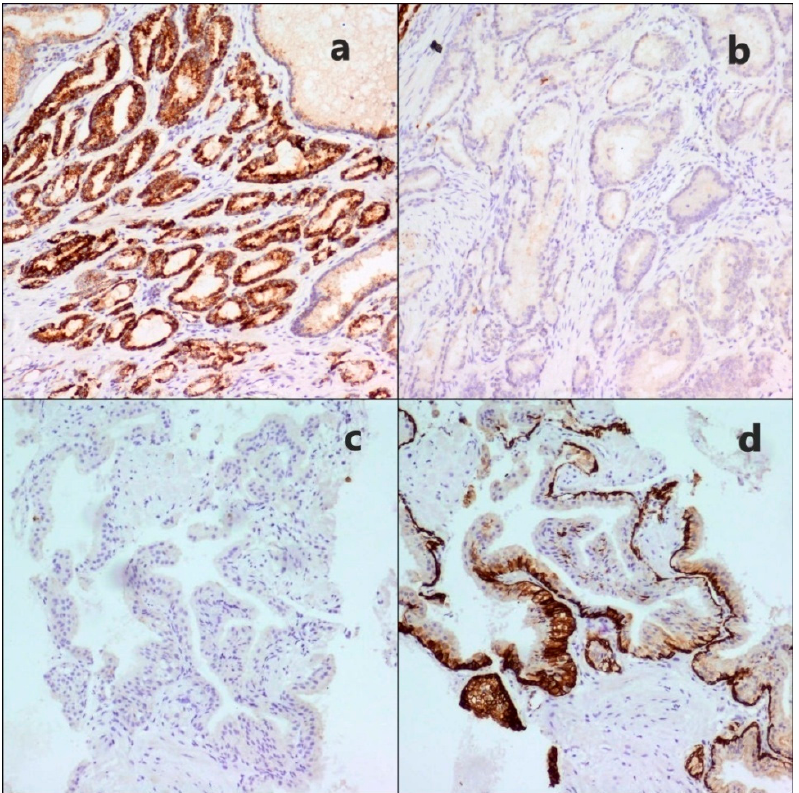
Figure 1. Comparison of immunohistochemical characteristics of prostate cancer and benign hy- perplasia. ( a ) Diffuse intense cytoplasmic staining of the neoplastic glands of adenocarcinoma with Alpha-Methylacyl-CoA Racemase (AMACR), ×40. ( b ) Negative basal cell staining with high-molecular-weight cytokeratin (HMWCK) of adenocarcinoma, ×40. ( c ) Benign hyperplasia tissue with negative expression of AMACR, ×20. ( d ) HMWCK expression in benign prostatic hyperplasia, ×20.